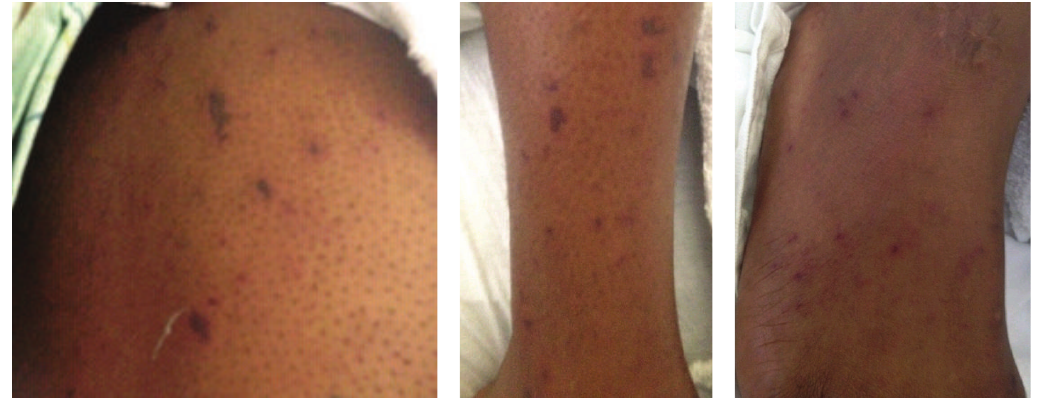
Figure 3: Skin findings.